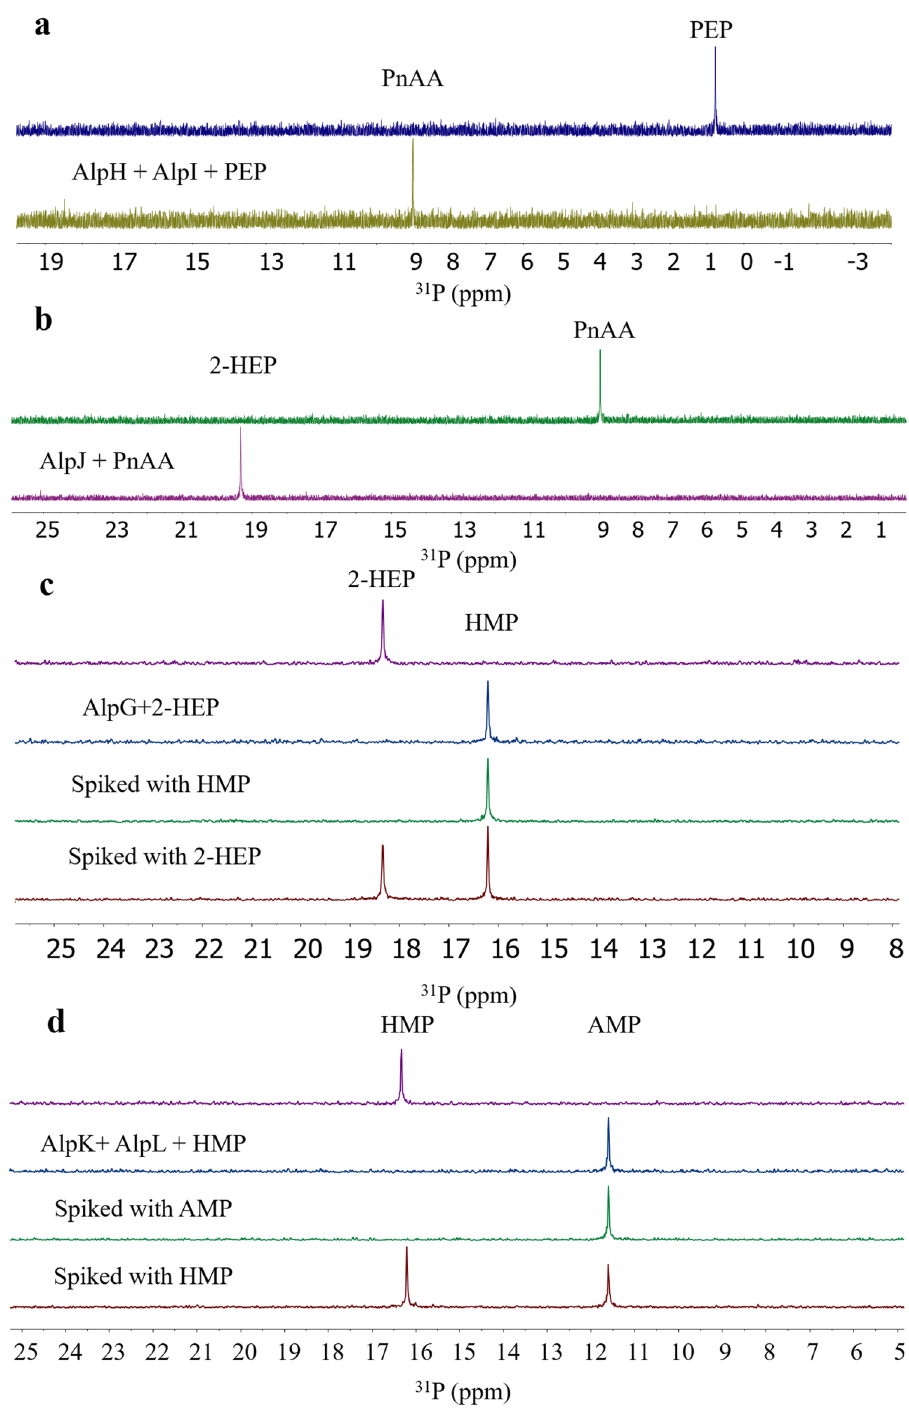
Fig. 6 Biochemical characterization of AlpG-L. a 31 P NMR spectrum of the incubation of His 6 -AlpH and His 6 -AlpI with PEP. b 31 P NMR spectrum of the incubation of His 6 -AlpJ with PnAA. c 31 PNMR spectrum of the incubation of His 6 -AlpG with 2-HEP. d 31 P NMR spectrum of the incubation of His 6 -AlpK and His 6 -AlpL with